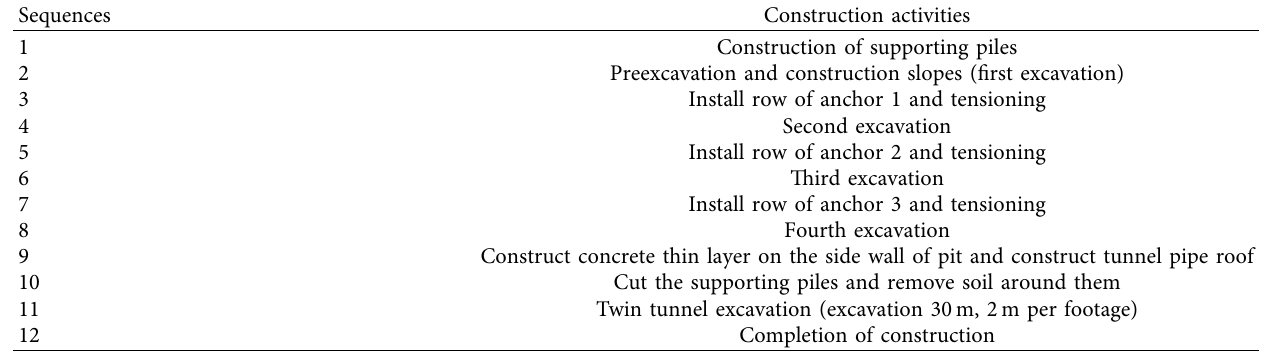
Table 2: The construction sequences of deep excavation.